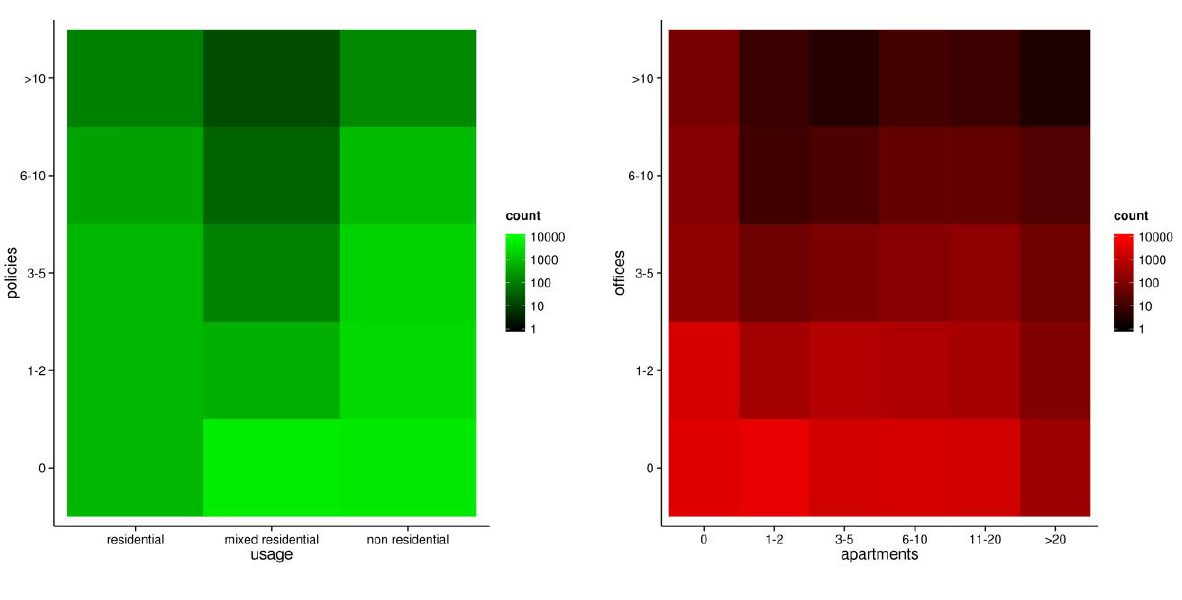
Figure 2. Distribution of policies with respect to buildings’ usage ( left ), and relative distribution of apartments and offices in the test areas ( right